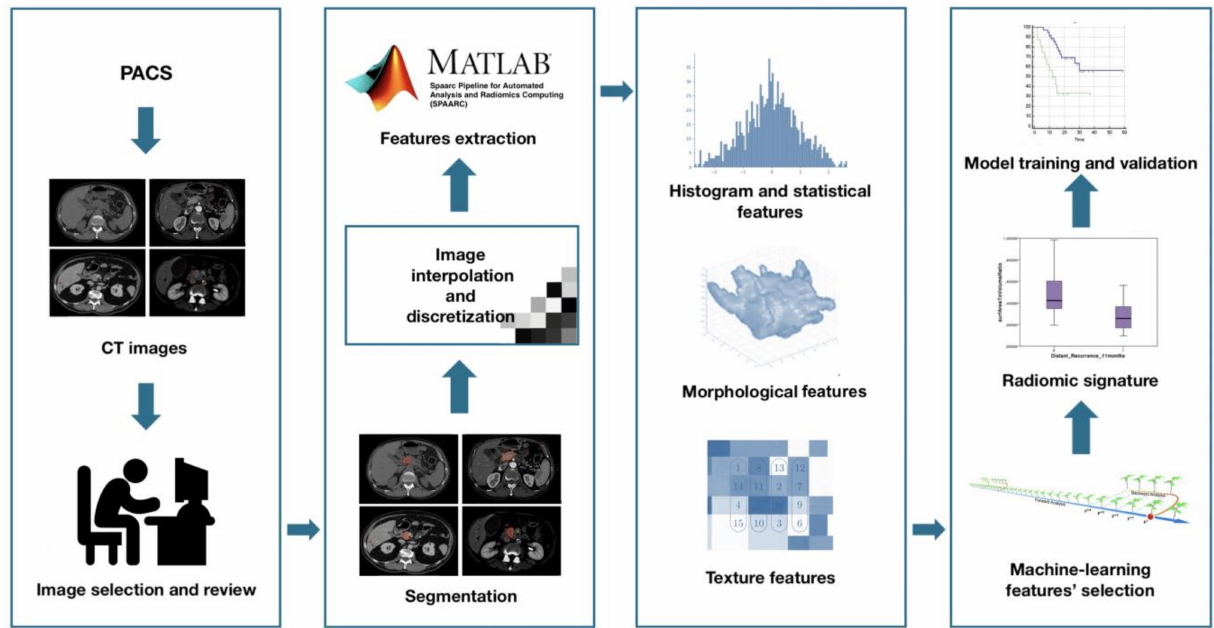
Figure 2. Radiomic features extraction